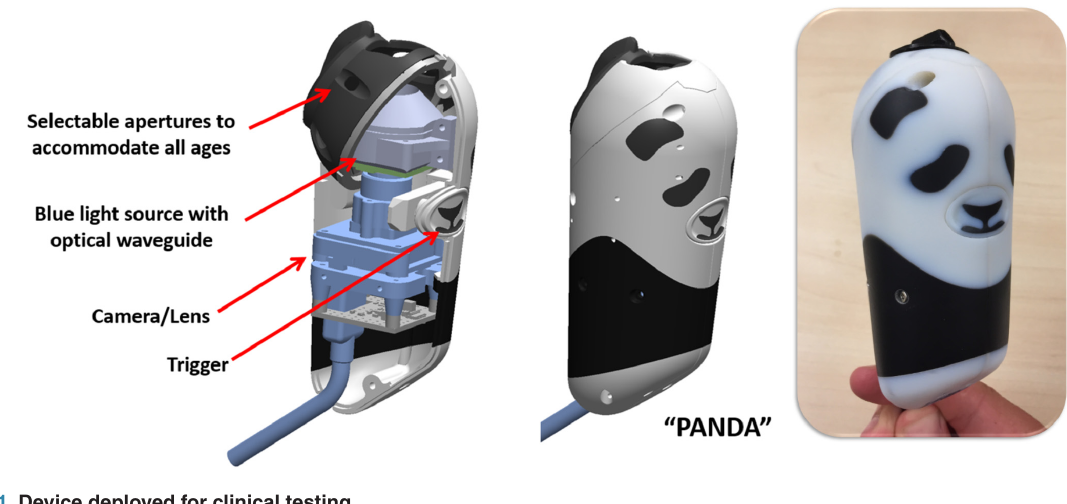
Figure 21. Device deployed for clinical testing.